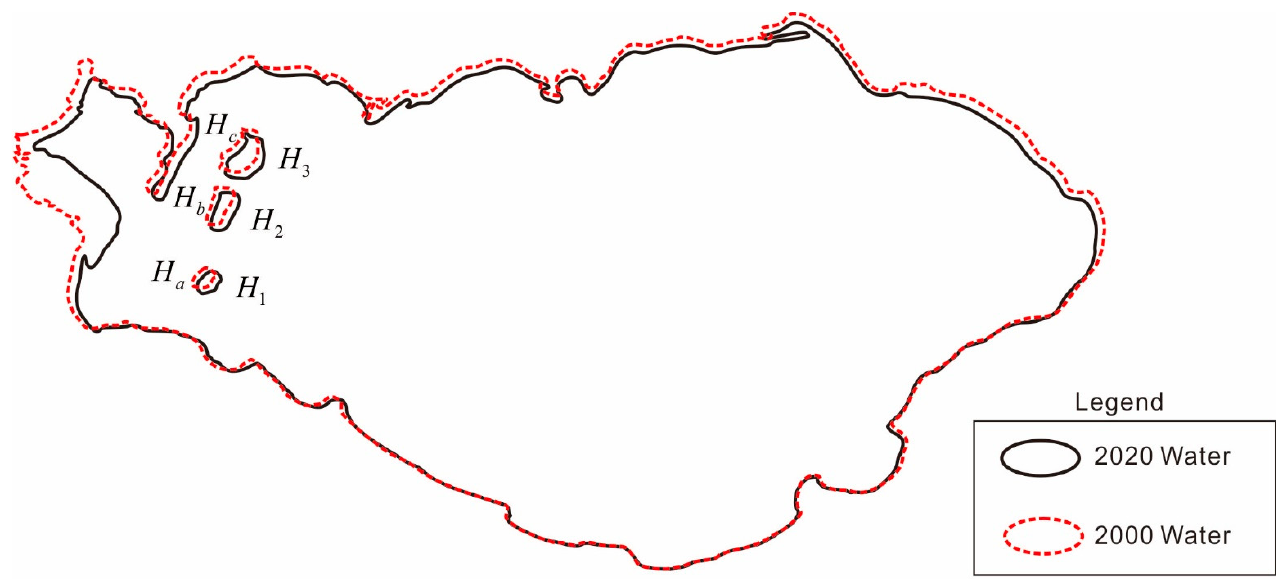
Figure 6. The change between water bodies of Lake Gyaring from 2000 to 2020 in GLOBELAND30. In order to show the ability of G9IM to describe topological relations between regions with holes, the 9IM, D9-intersection model, 25-intersection model, and G9IM were used to describe the topological relations of changes in the water body of Lake Gyaring from 2000 to 2020 in GLOBELAND30. Sandbars in Lake Gyaring were reduced from 3 to 0 (Figure 7) for distinguishing abilities of the four different models. The description results of the topological relation are shown in Table 5. It can be seen that G9IM could fully identify the changes in sandbars in Lake Gyaring, while the other three models could not fully distinguish them.